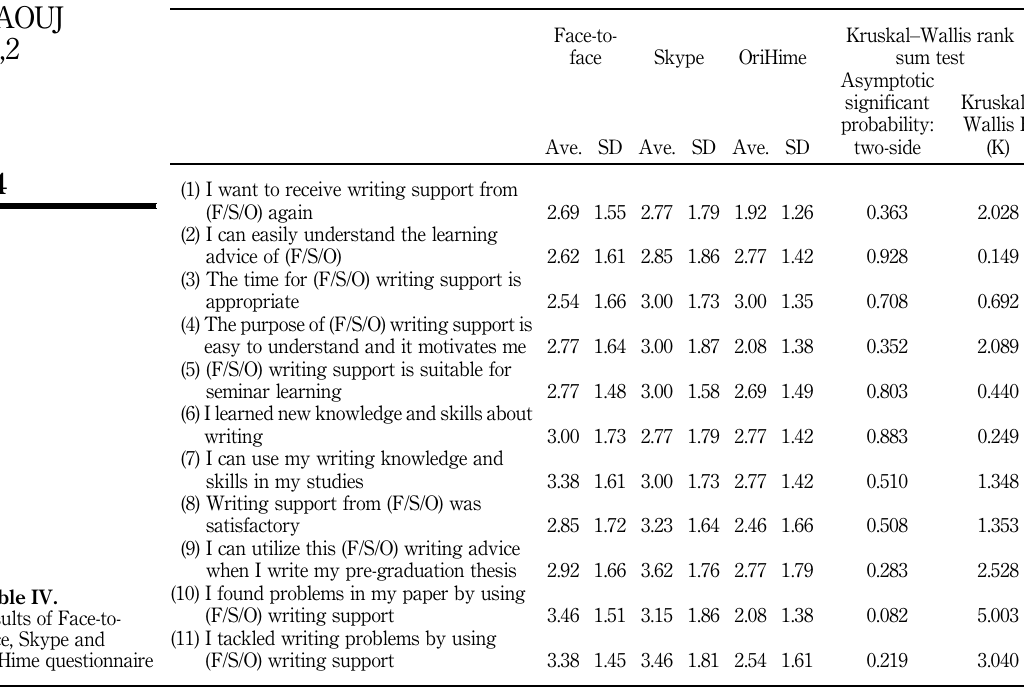
Table IV. Results of Face-to- Face, Skype and OriHime